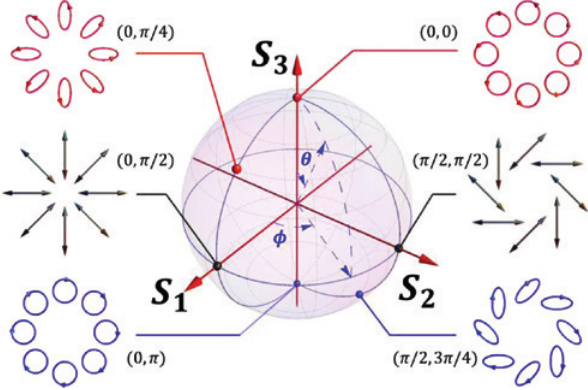
Figure 4: Higher-order Poincaré sphere ( l = 1): the poles ( θ = 0, π ) represent orthogonal circular polarizations with different optical vortex ( l = ± 1). Equatorial points ( θ = π /2) represent generalized cylindrical vector beams; ( φ = 0; θ = π /2) and ( φ = π ; θ = π /2) represent radial and azimuthal vector beams, respectively; ( φ = π /2; θ = π /2) and ( φ = 3 π /4; θ = π /2) represent spiral polarizations. Intermediate points between the poles and equator represent elliptically polar- ized cylindrical vector